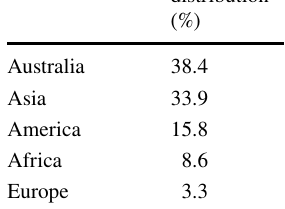
Table 1 Region-wise salinity distribution (Tellaeche et al. 2011)